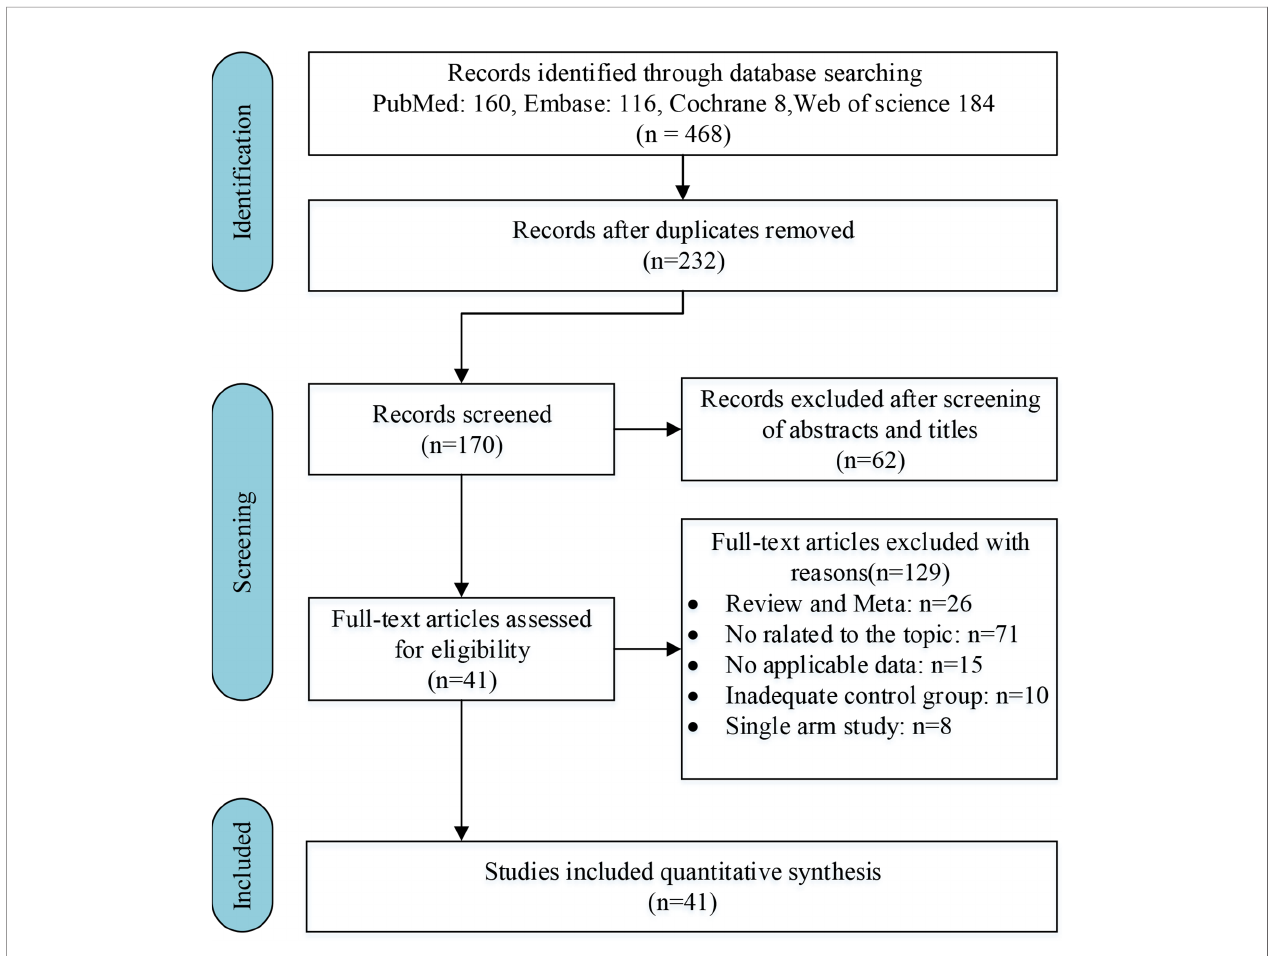
FIGURE 1 | Flow chart of the search process for the